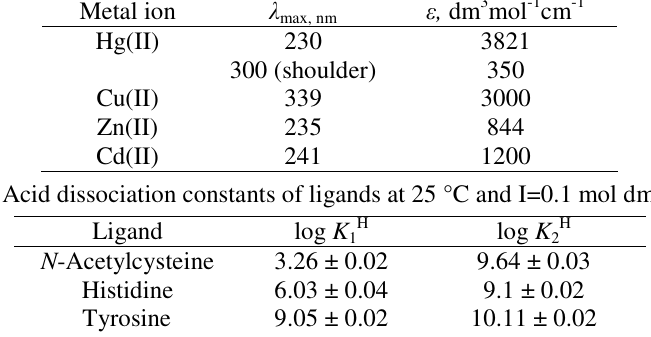
Table 1 . Principal electronic transitions in NAC-metal(II) complexes in terms of maximum